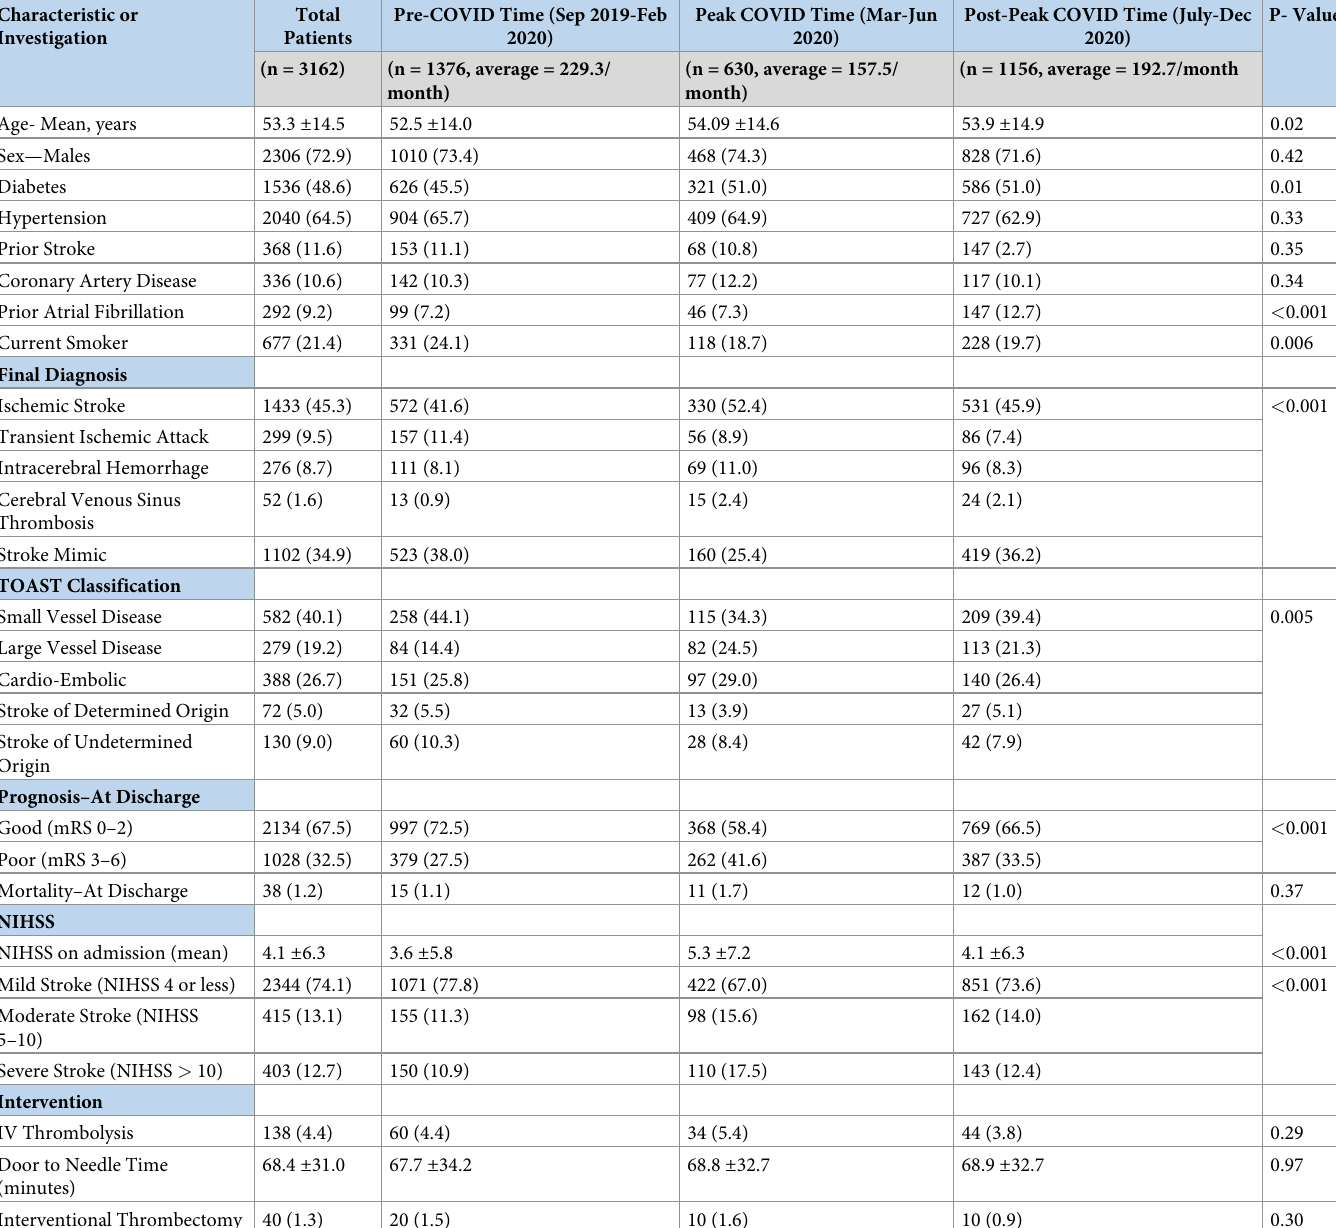
Table 1. The details of the admissions, risk factors, TOAST classification, prognosis and interventions is shown for the pre-COVID-19, during the peak of the pan- demic and in the six months following the peak of the pandemic. Characteristic or Total Investigation